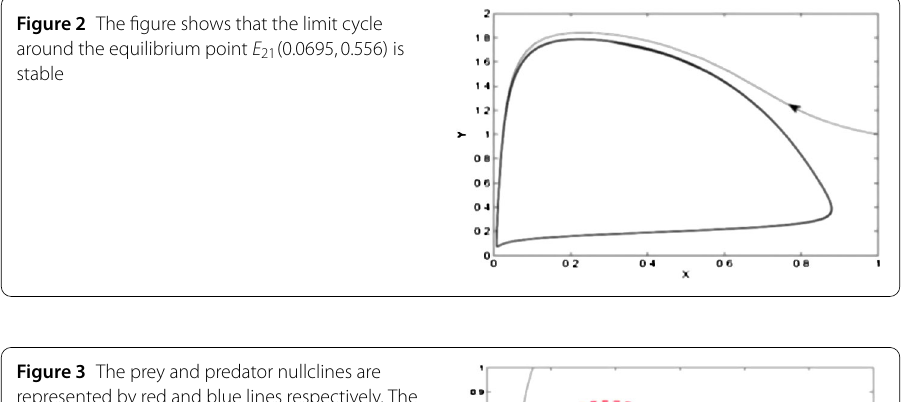
Figure 3 The prey and predator nullclines are represented by red and blue lines respectively. The equilibrium point E ∗ (0.9169,0.1223) is stable focus